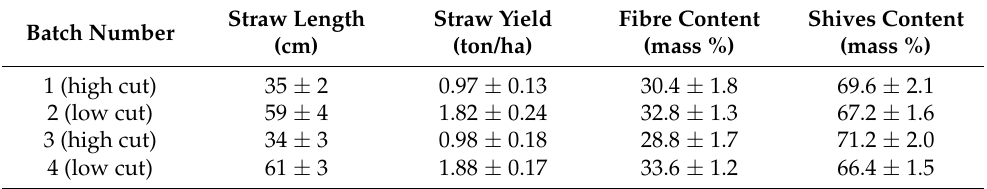
Table 3. Contents of fibres and shives in the different straw batches tested (determination through manual extraction).